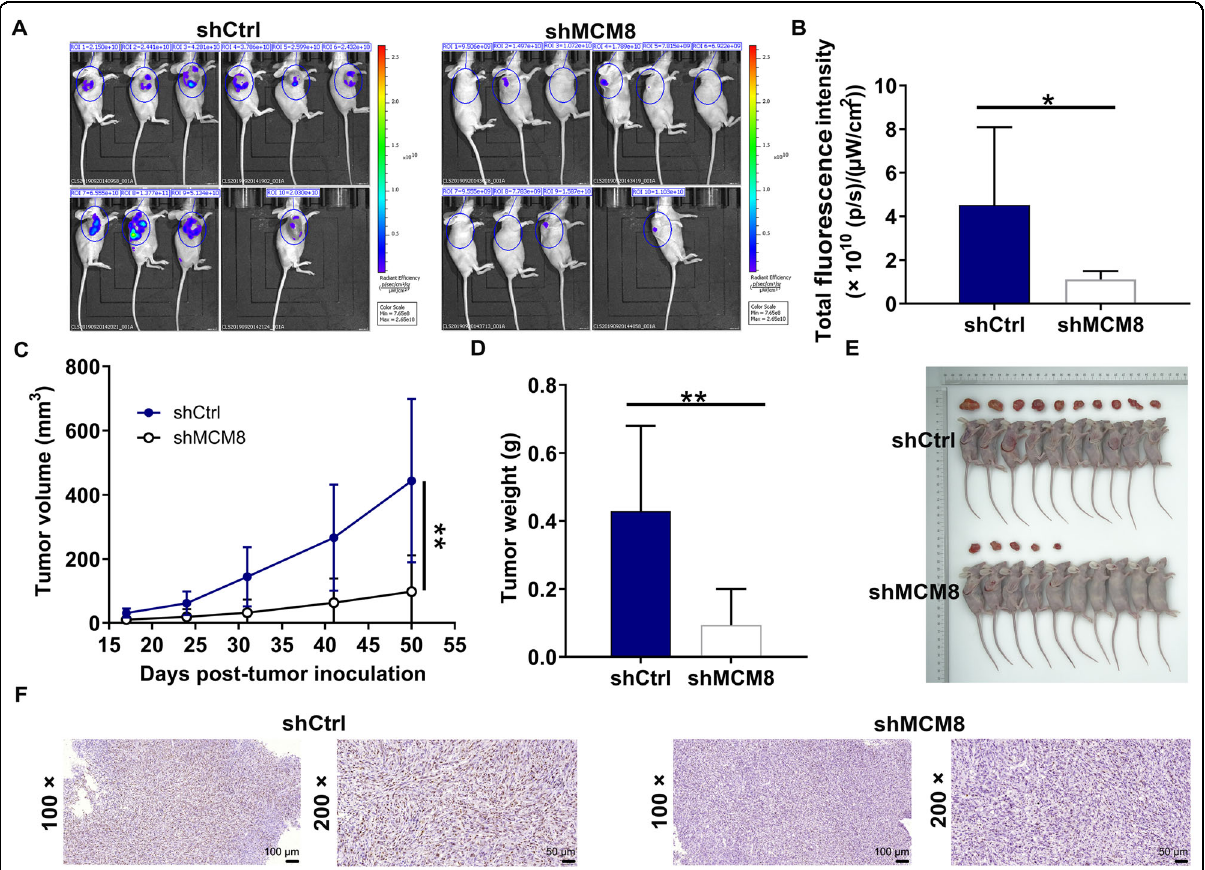
Fig. 3 MCM8 knockdown suppressed osteosarcoma growth in vivo. A A nude mice model of MCM8 knockdown through injecting MNNG/HOS cells was constructed. B The fl uorescence intensity was obtained through injection of D-Luciferase before sacri fi cing the mice. C The volume of tumors was tested from feeding to sacri fi ce. D The weight of tumors was measured after sacri fi cing mice. E The photograph of tumors was taken after removing tumors. F The value of Ki-67 was detected by IHC in tumor sections. Results were presented as mean ± SD. * P < 0.05, ** P <